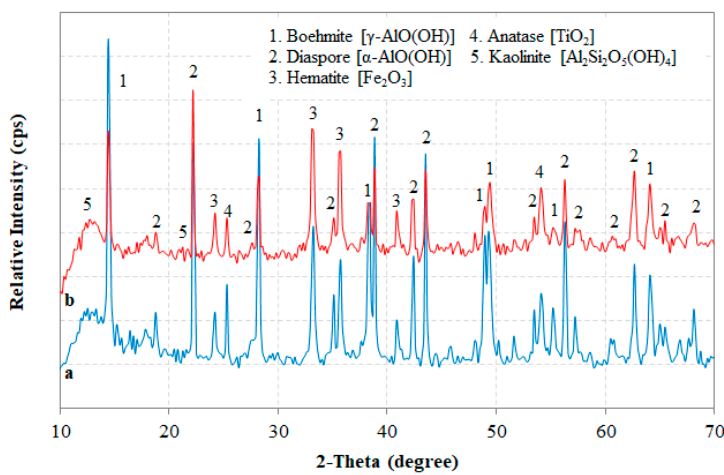
Figure 16. XRD patterns of ( a ) non-magnetic product NMI and ( b ) magnetic product MIII obtained after magnetic separation of the − 0.300 mm fraction.